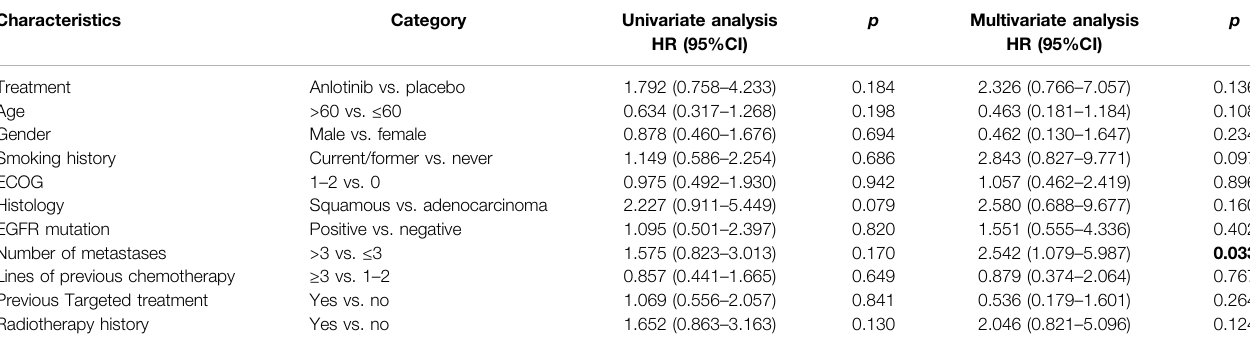
TABLE 3 | Univariate and multivariable analyses for variables associated with OS in the obesity group ( n = 49). Characteristics